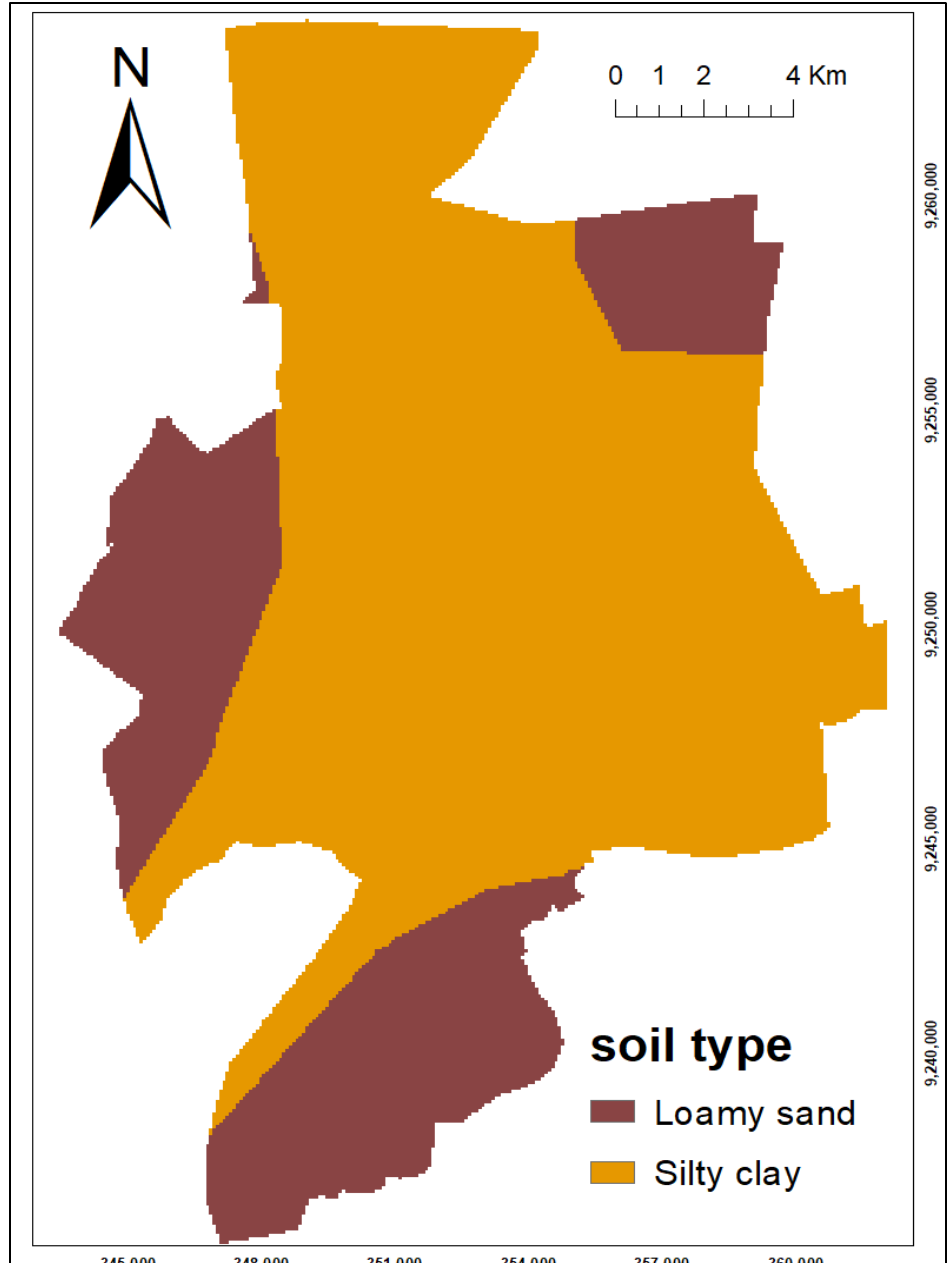
Figure 7. Soil media map.